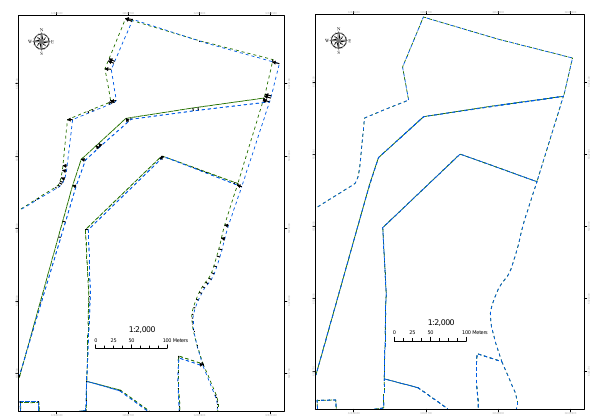
Figure 9: Polygonal databases alignment: subject (dashed blue) and reference (dashed green): before (left) and after (right); vector fields in black arrows Parameter Used Calculated Difference